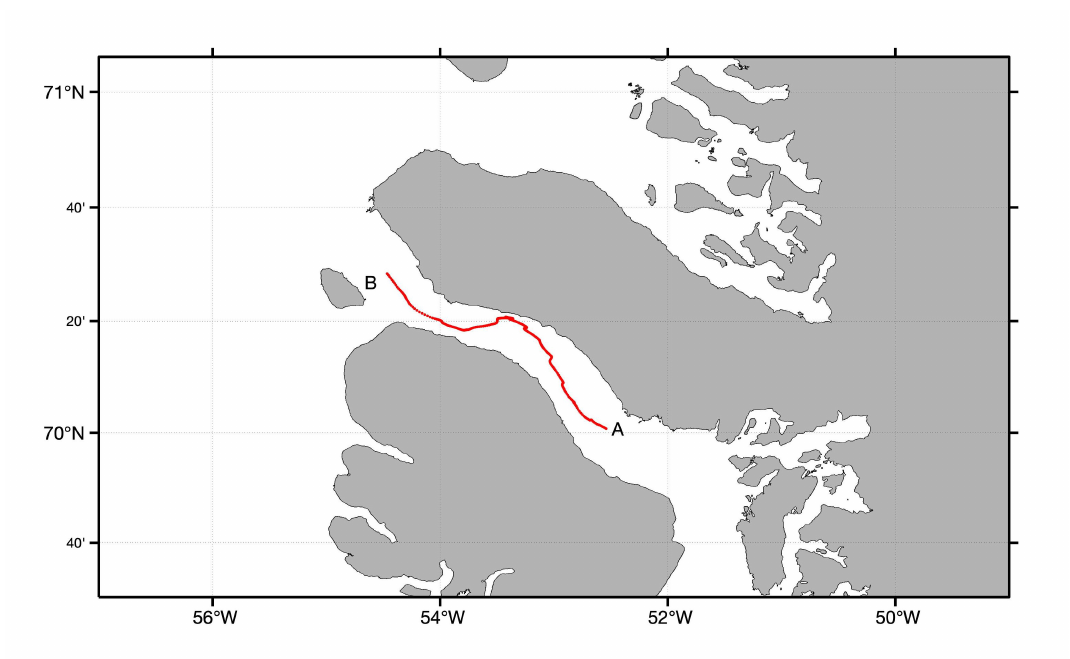
Figure 12. The drifting mooring’s trajectory through the Vaigat Strait from 4–12 August 2019. The mooring was deployed at point A and retrieved at point